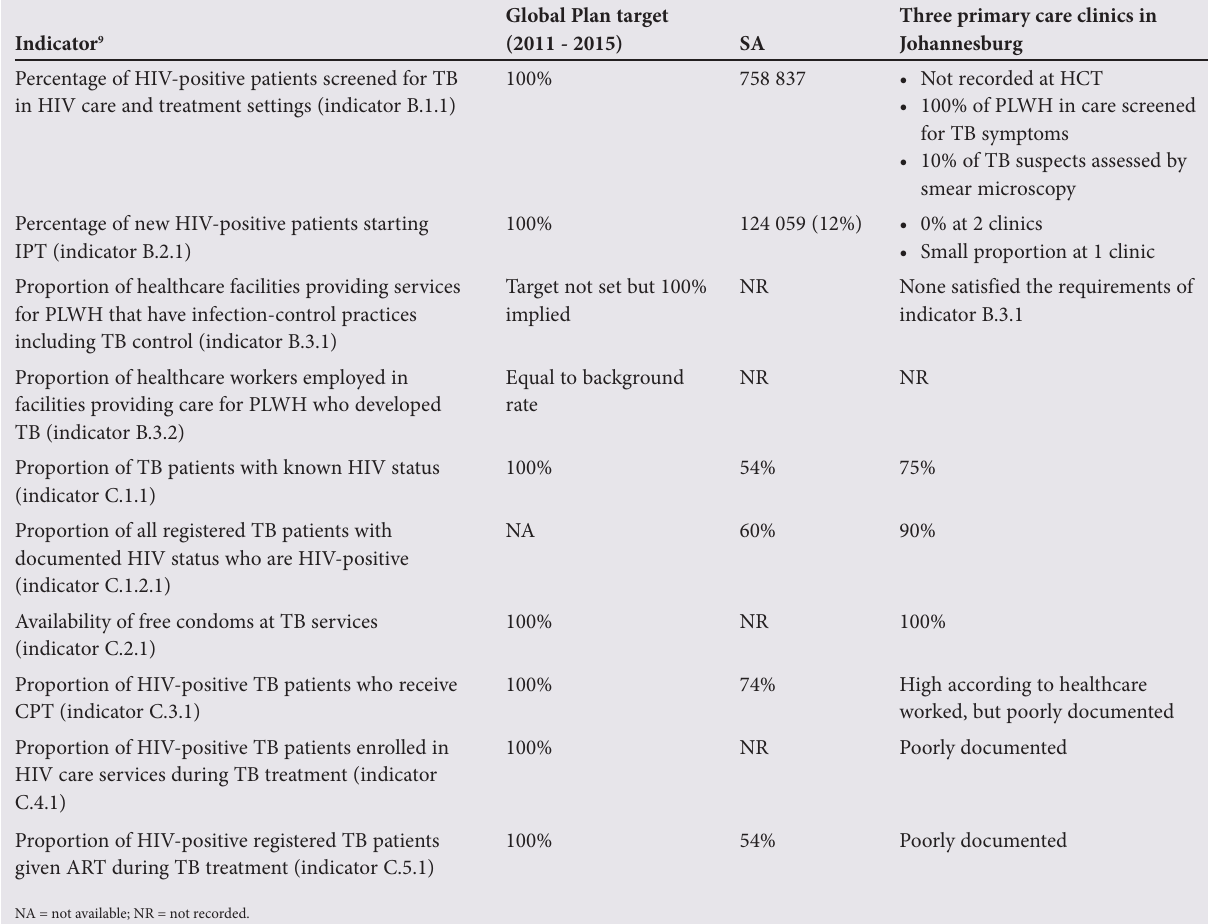
Table 4. Coverage of TB/HIV activities compared with 2010 estimates for SA 1 and The Global Plan to Stop TB targets 3